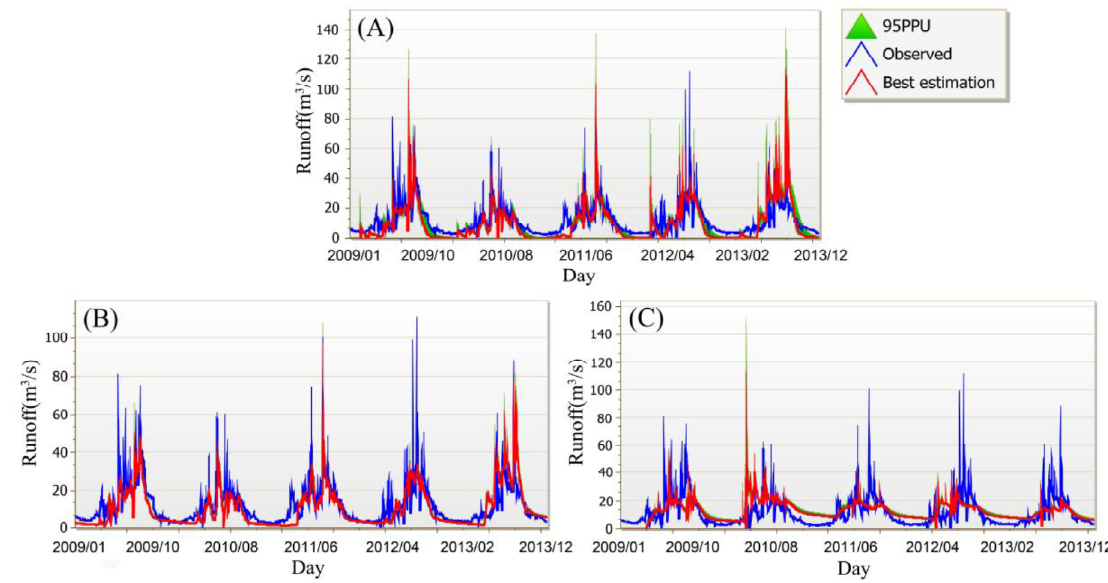
Figure 9. Daily runoff simulation results of three different modes at Qilian Mountain control station from 2009 to 2013: ( A ) CMADS + SWAT mode; ( B ) TWS + SWAT mode; ( C ) CFSR + SWAT mode.